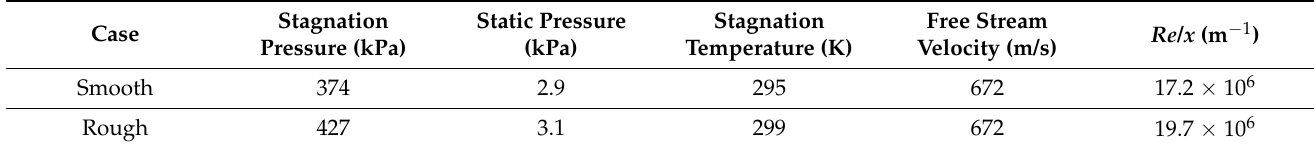
Table 1. UTSI Mach 4 wind tunnel test conditions for the present test campaign.